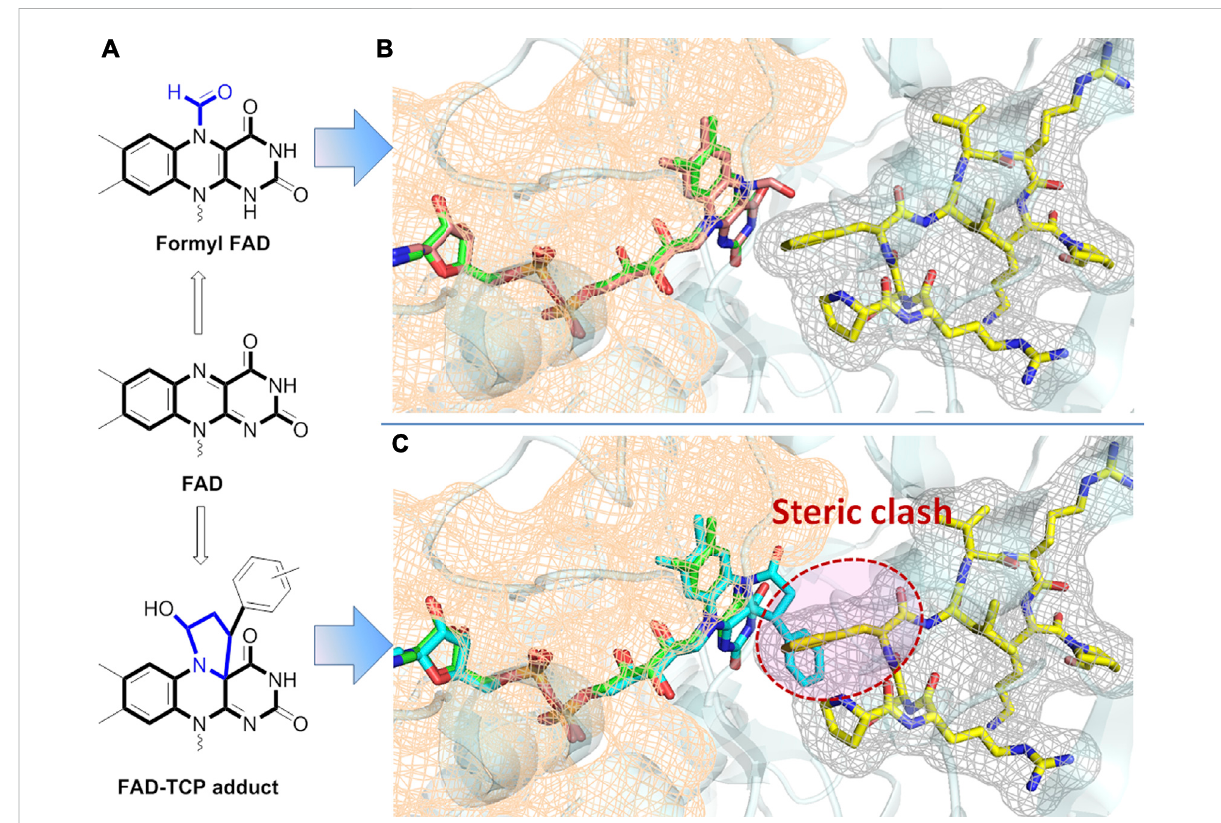
FIGURE 4 (A) ChemicalstructuresofadductsofFADwithTCPintwodifferentways; (B) Superimposed structureofformyl